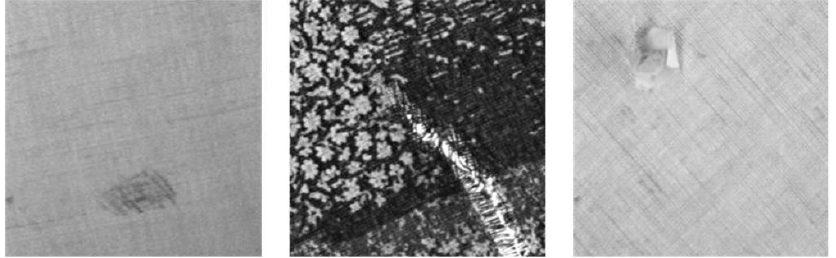
Figure 10. Three representative repeated pattern-free fabric images from the TILDA database.